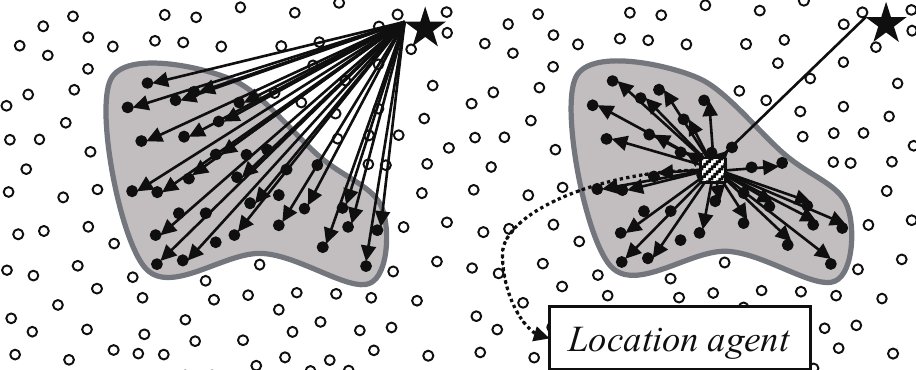
Figure 7. Location updates to the sources detecting a continuous object: ( left ) Individual location updates and ( right ) Integrated location updates.